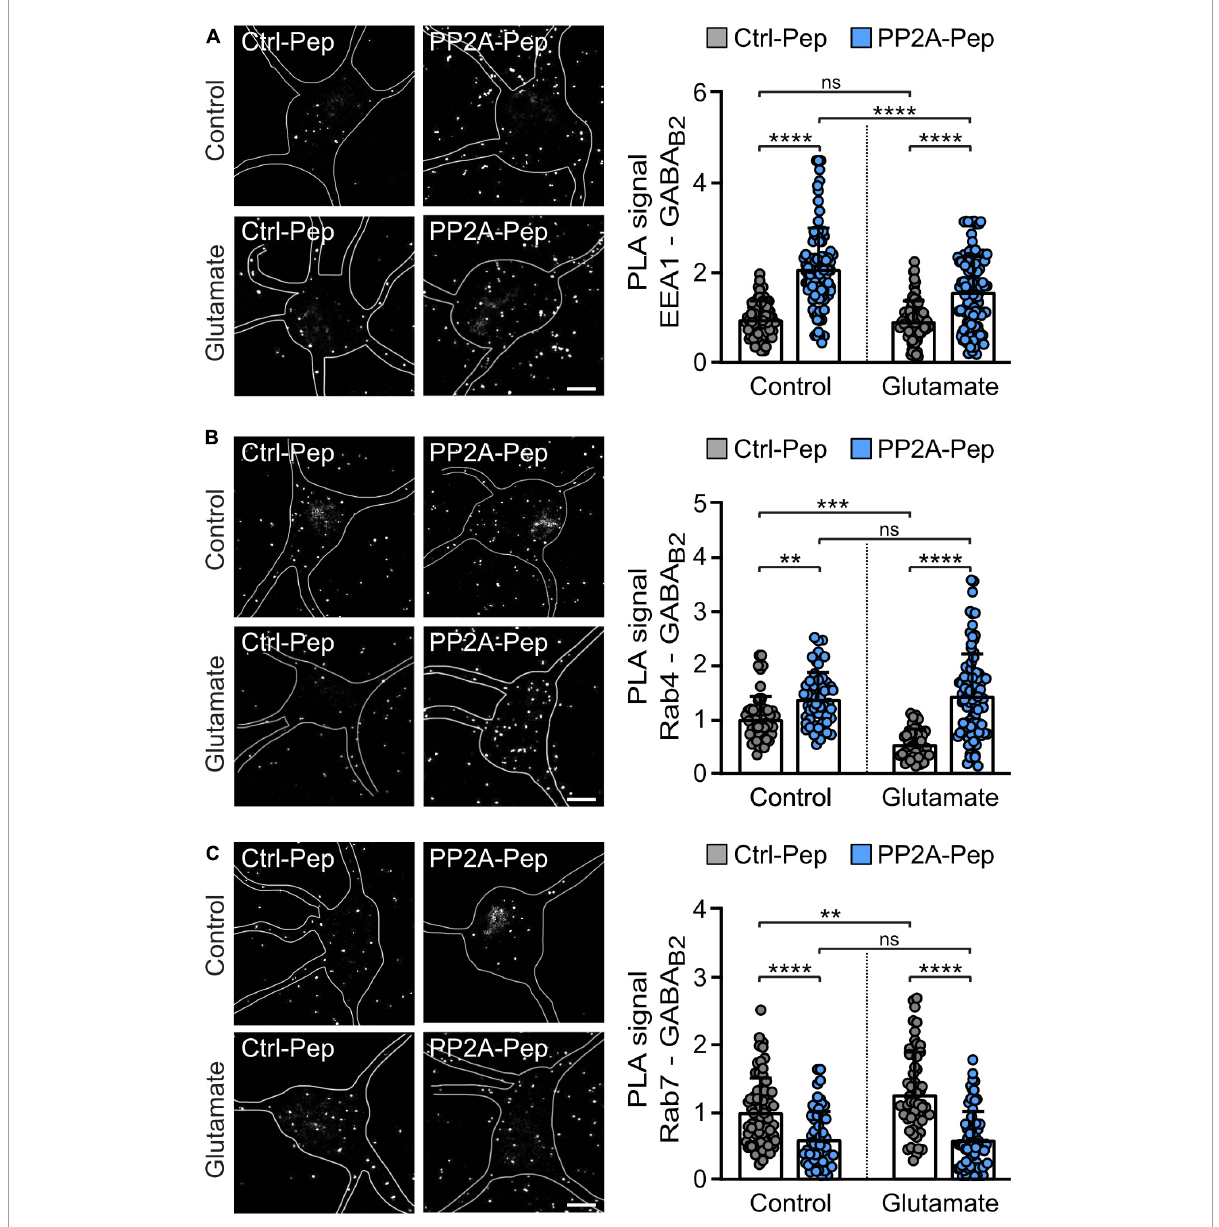
FIGURE5 PP2A-Pep increased fast recycling of GABA B receptors and reduced their sorting to lysosomal degradation. Cultured neurons were stressed or not (control) with glutamate (50 µ M for 1 h) followed by incubation with PP2A-Pep. Neurons were then analyzed for the colocalization of GABA B receptors with endosomal markers by in situ PLA using antibodies directed against GABA B2 and EEA1 (A) , Rab4 (B) , and Rab7 (C) . The location and shape of neurons analyzed in the representative images are outlined. Please note that PLA signals outside of the outlined neurons are associated with dendrites of adjacent neurons, which were not marked. (A) PP2A-Pep treatment increased the colocalization of GABA B receptors with the early endosome marker EEA1. Left: representative images (scale bar, 10 µ m). Right: quantification of PLA signals (white dots). The data represent the mean ± SD of 94–114 neurons per condition from five independent experiments. Two-way ANOVA followed by Tukey’s multiple comparison test (ns, p > 0.05; **** p < 0.0001). (B) PP2A-Pep treatment increased the colocalization of GABA B receptors with the fast-recycling endosome marker Rab4. Left: representative images (scale bar, 10 µ m). Right: quantification of PLA signals. The data represent the mean ± SD of 42–93 neurons per condition from three independent experiments. Two-way ANOVA followed by Tukey’s multiple comparison test (ns, p > 0.05, ** p < 0.005, *** p < 0.0005, **** p < 0.0001). (C) PP2A-Pep treatment reduced colocalization of GABA B receptors with the late endosome marker Rab7. Left: representative images (scale bar, 10 µ m). Right: quantification of PLA signals. The data represent as mean ± SD of 58–74 neurons per condition from three independent experiments. Two-way ANOVA followed by Tukey’s multiple comparison test (ns, p < 0.05, ** p < 0.01, **** p <